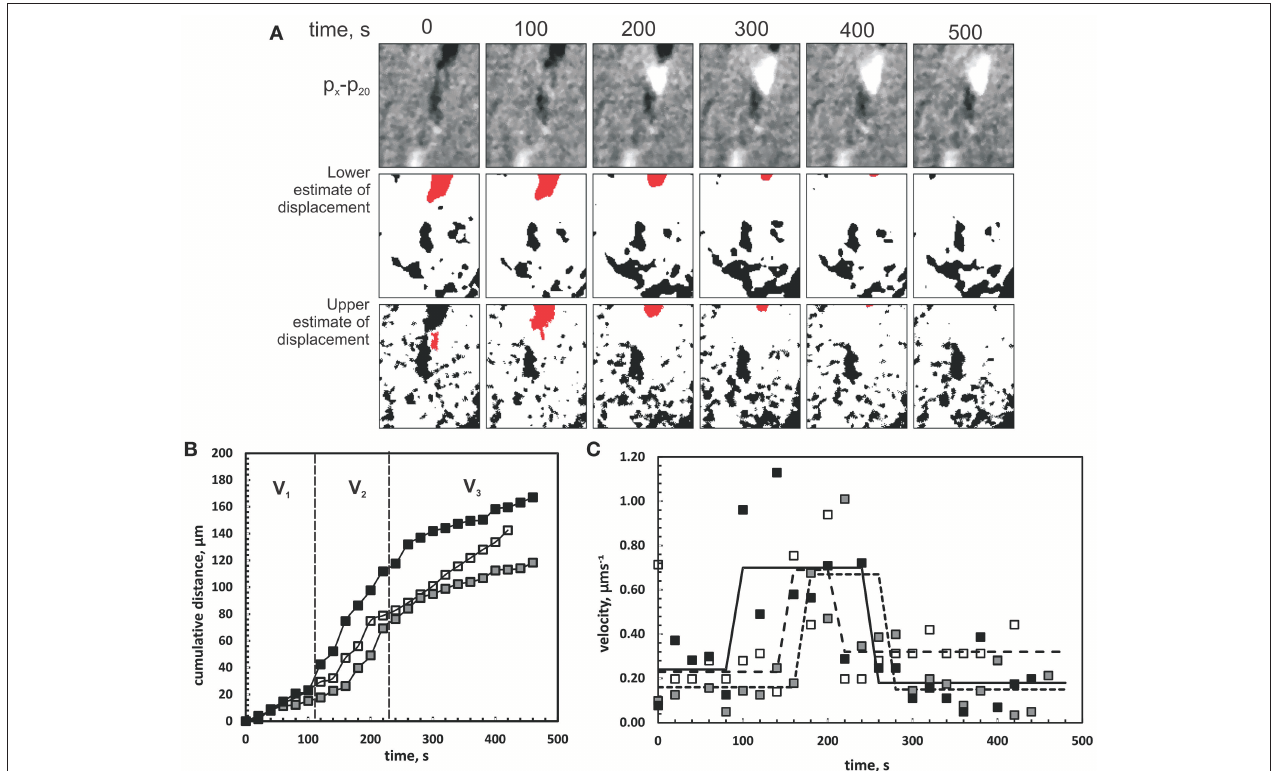
FIGURE 7 | Example of melt motion tracking of event M2 by image analysis of 2D radiographic projections. (A) Series of stills showing motion of interest over a time interval of 500s. Top: grayscale p x -p 20 images highlighting melt movement. Image filtered using ImageJ “remove outliers” function to reduce noise. Middle: Same image thresholded at minimum grayscale estimate, and Bottom: at maximum estimate, with melt volume of interest highlighted. (B) Time-displacement graph of tracked lower left pixel from the melt volumes in (A) for three threshold values (Black squares: 130, Open squares: 125, Gray squares: 119). Although the overall displacement varies for each valued used, the overall trend of the data is similar, revealing marked changes in apparent velocity, shown here as three fields, V 1 to V 3 . (C) . Determined velocities based on (B) for the threshold values used. Averaged velocity for each is also shown (Solid: 130, Dashed: 125, Dotted: 119). Although there is scatter in the dataset, averaged velocities are relatively consistent for different thresholds, with minor differences only in the timing of changes in melt